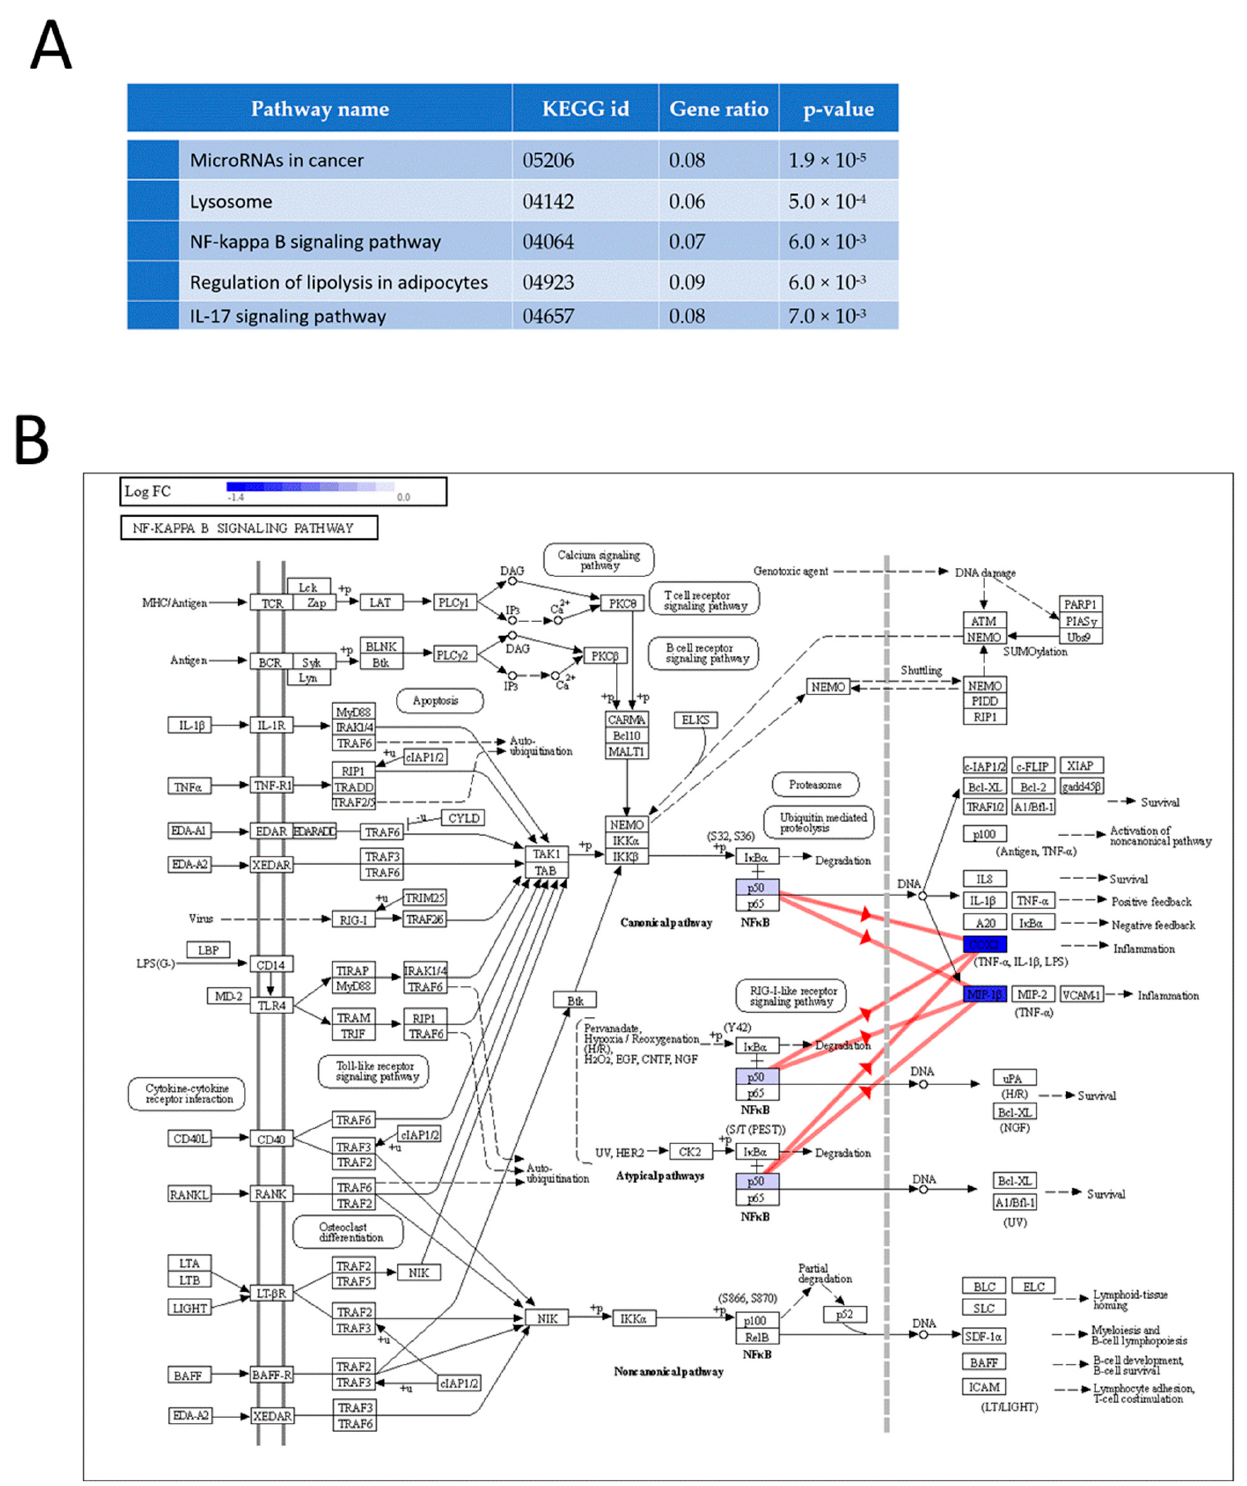
Figure 5 . Proteomic pathway impact analysis. ( A ) Top five impacted pathways according to the proteomic analysis. ( B ) Effect of inulin on the NF- κ B signaling pathway of LPS-activated RAW 264.7 cells, highlighting regulated proteins and showing coherent cascades.